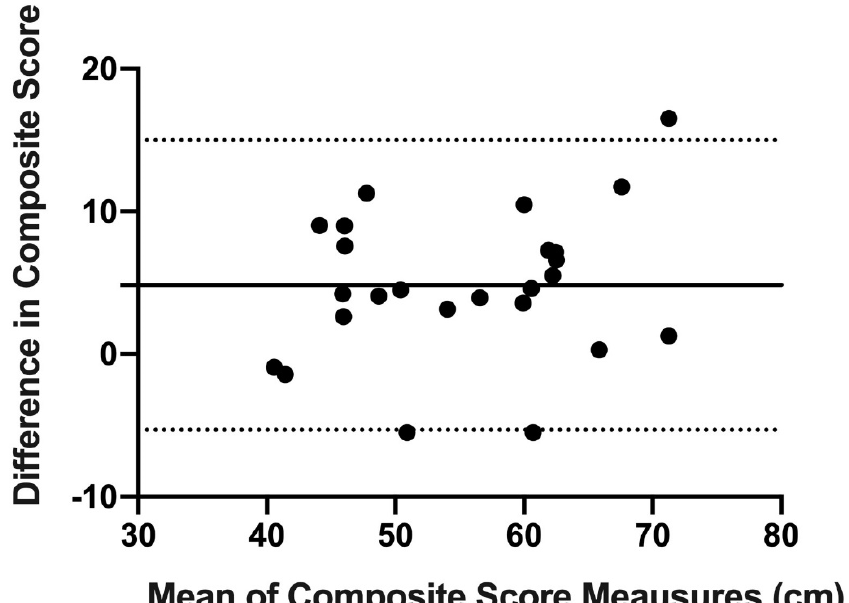
Figure 10. Bland–Altman left superolateral.